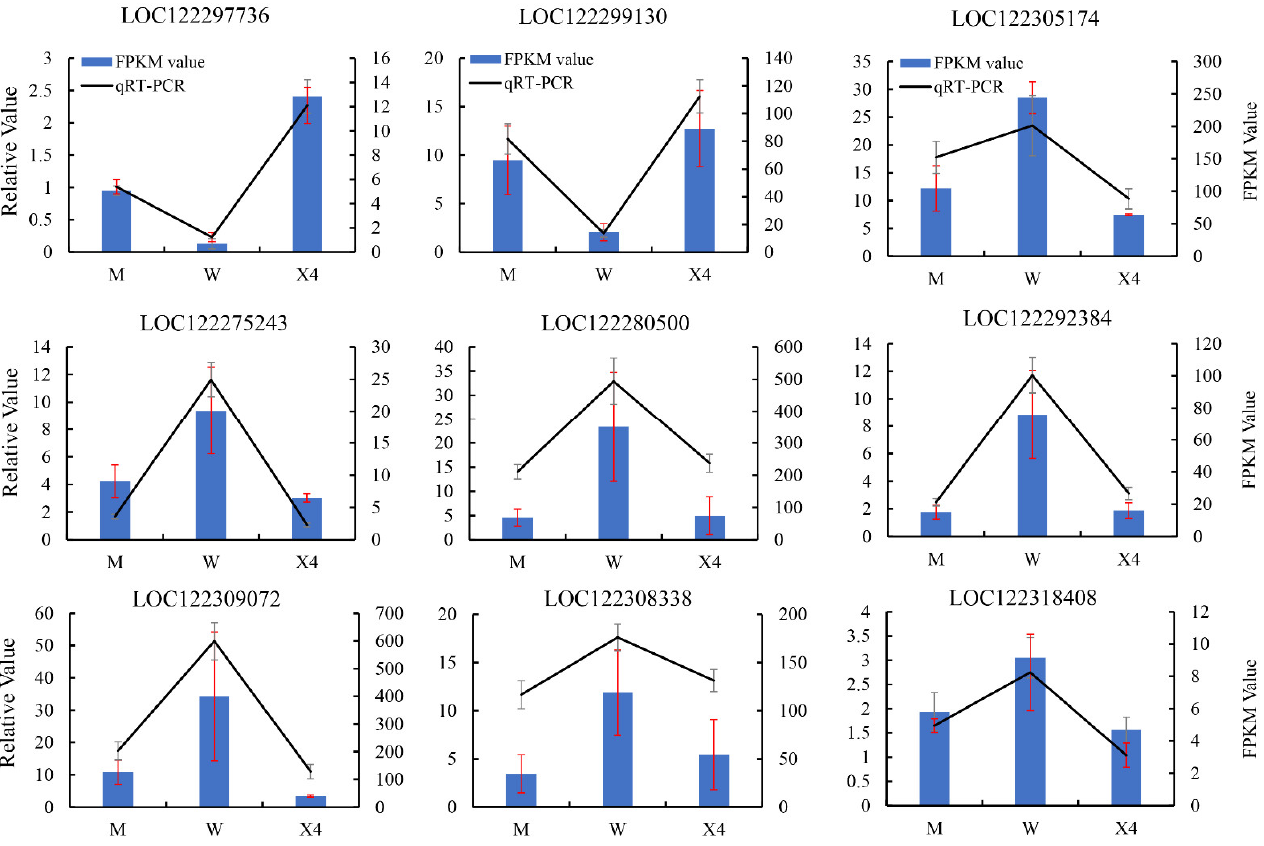
Figure 8. qRT-PCR validation of DEGs in three pecan fruit cultivars after FBS infection. Black line: qRT-PCR expression; blue bars: transcriptomic RNA-Seq analysis (FPKM). Primers and annotations of nine genes are listed in Supplementary Table S8.